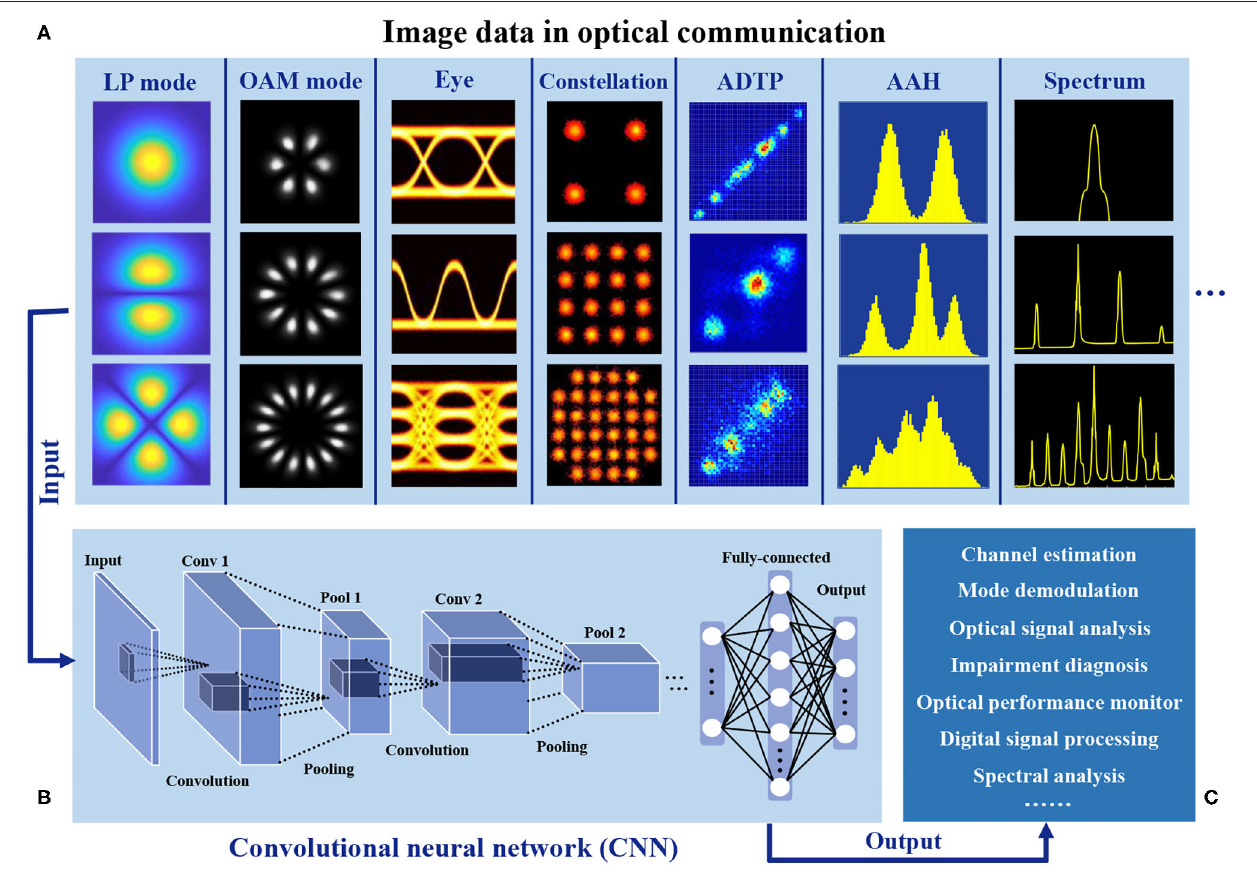
FIGURE 2 | Application of convolutional neural network (CNN) in optical communication for image processing. (A) Summarization of image data in optical communication: linear polarization (LP) mode diagrams, orbital angular momentum (OAM) mode diagrams, eye diagrams, constellation diagrams, asynchronous delay-tap plot (ADTP) diagrams, asynchronous amplitude histograms (AAH) diagrams, and optical spectrum diagrams. (B) The structure of CNN is composed of convolution layers, pooling layers, and fully-connected layers. (C) A variety of functions can be achieved by CNN for optical communication.